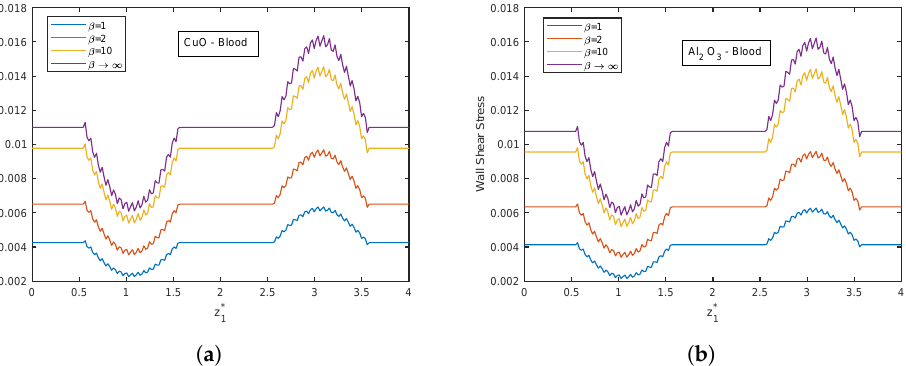
Figure 26. Wall shear stress profiles of Casson fluid parameter β for ( a ) CuO-nanoparticles, ( b ) Al 2 O 3 -nanoparticles.